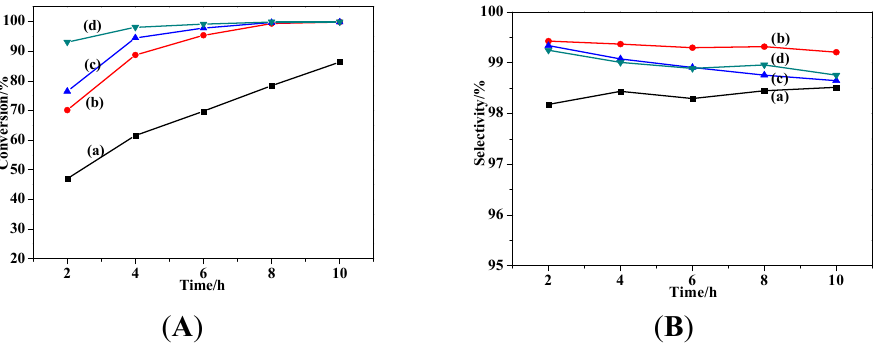
Figure 9. Effect of temperature and time on ( A ) conversion and ( B ) selectivity. (a): 0.01 g; (b):0.02 g; (c): 0.03 g; (d): 0.04 g.